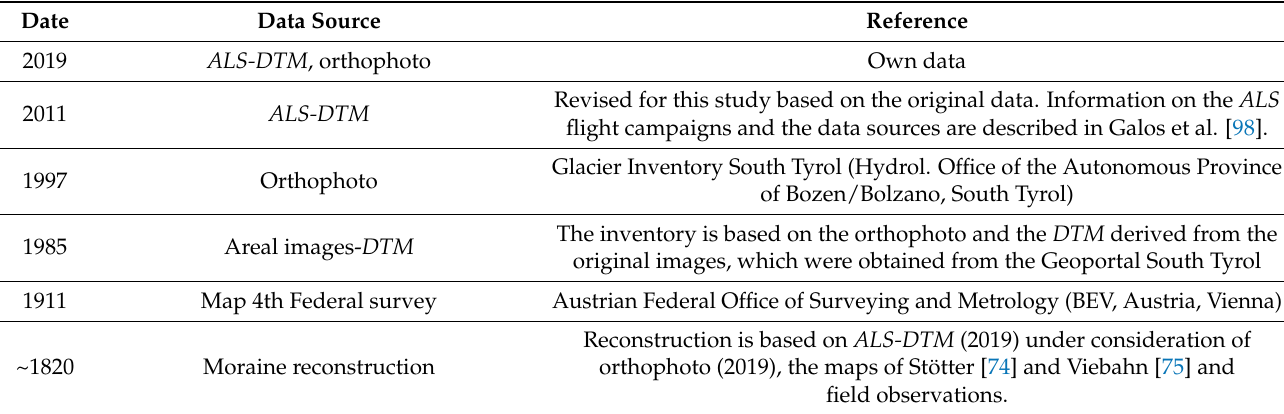
Table 2. Dates, data sources and references of the glacier inventories used to analyse the evolution of the glacier forelands.